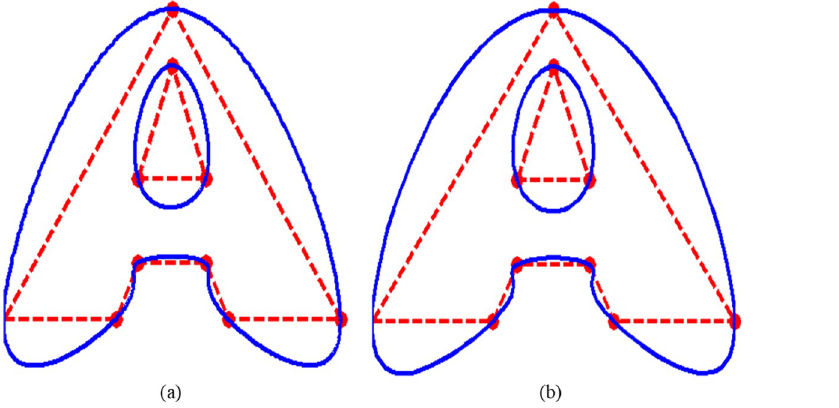
Fig 8. Data of the letter “A” is interpolated: (a) by CPS; (b) by QTS.